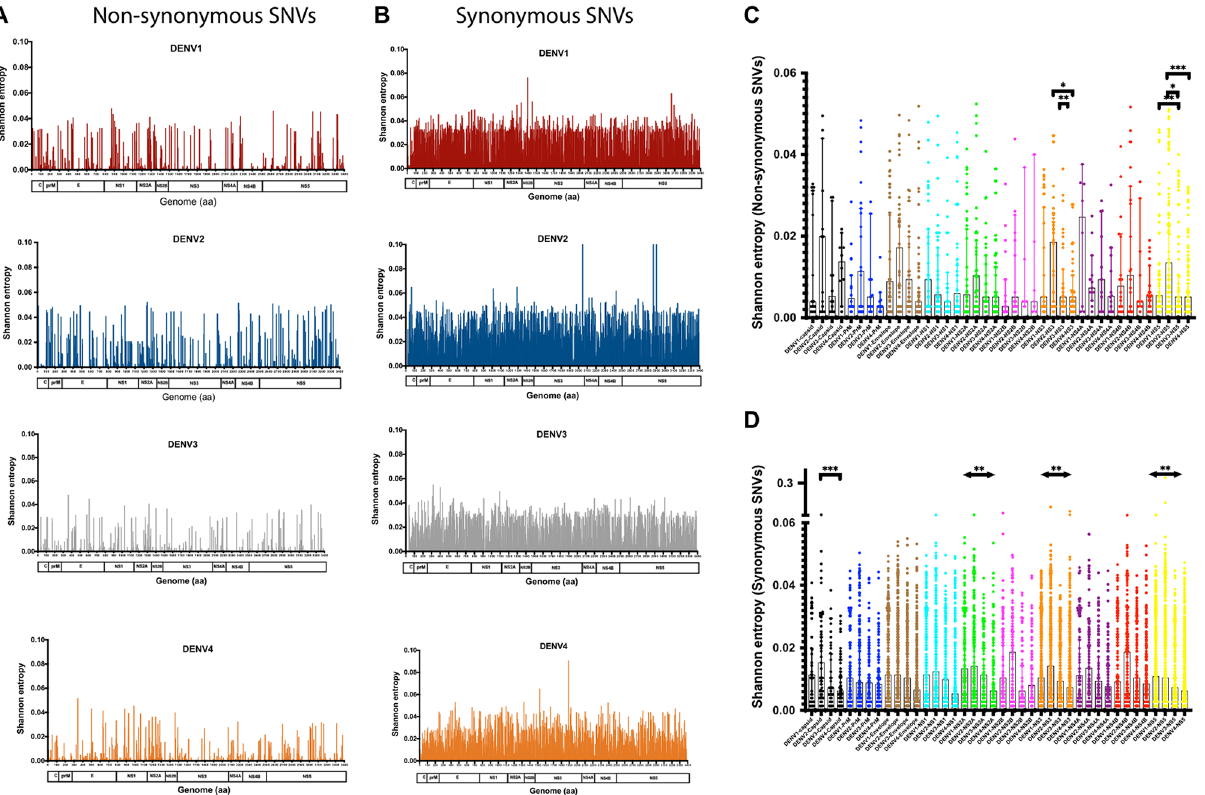
Figure 2. Viral diversity analysis of DENV genomes. Viral diversity using Shannon entropy measures from the distribution of SNVs across the four serotypes from non-synonymous ( A ) and synonymous ( B ). Analysis within sub-genomic regions utilizing non-synonymous ( C ) and synonymous ( D ) SNVs across the four serotypes revealed significant differences within NS3 and NS5. Statistical tests performed using non-parametric Mann– Whitney U test. Shannon entropy values are colour-coded by